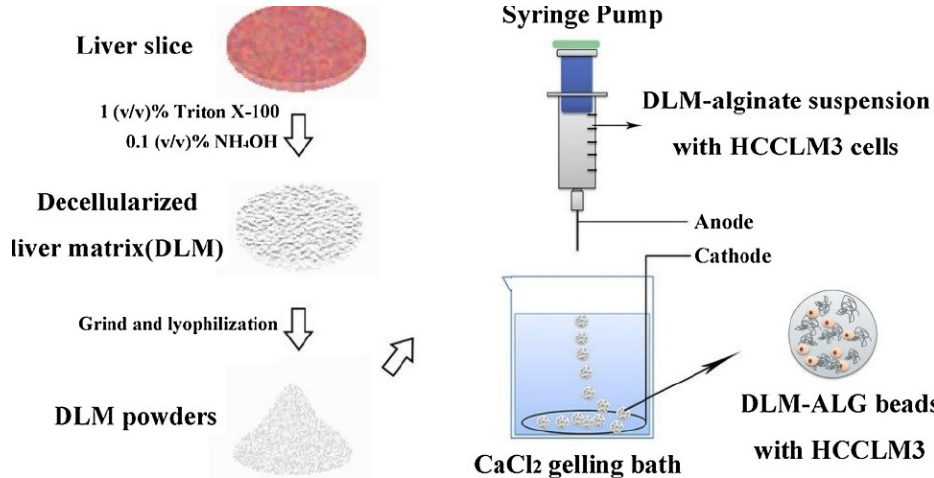
Figure 5. Schematic illustration of the preparation of decellularized liver matrix (DLM) and decellularized liver matrix–alginate hybrid gel beads (DLM–ALG beads). Reprinted with permission from Elsevier [92].